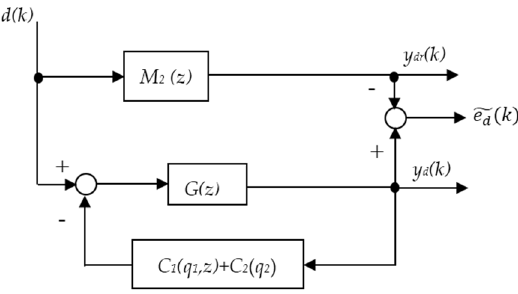
Figure 3. 2DOF closed loop disturbance system.